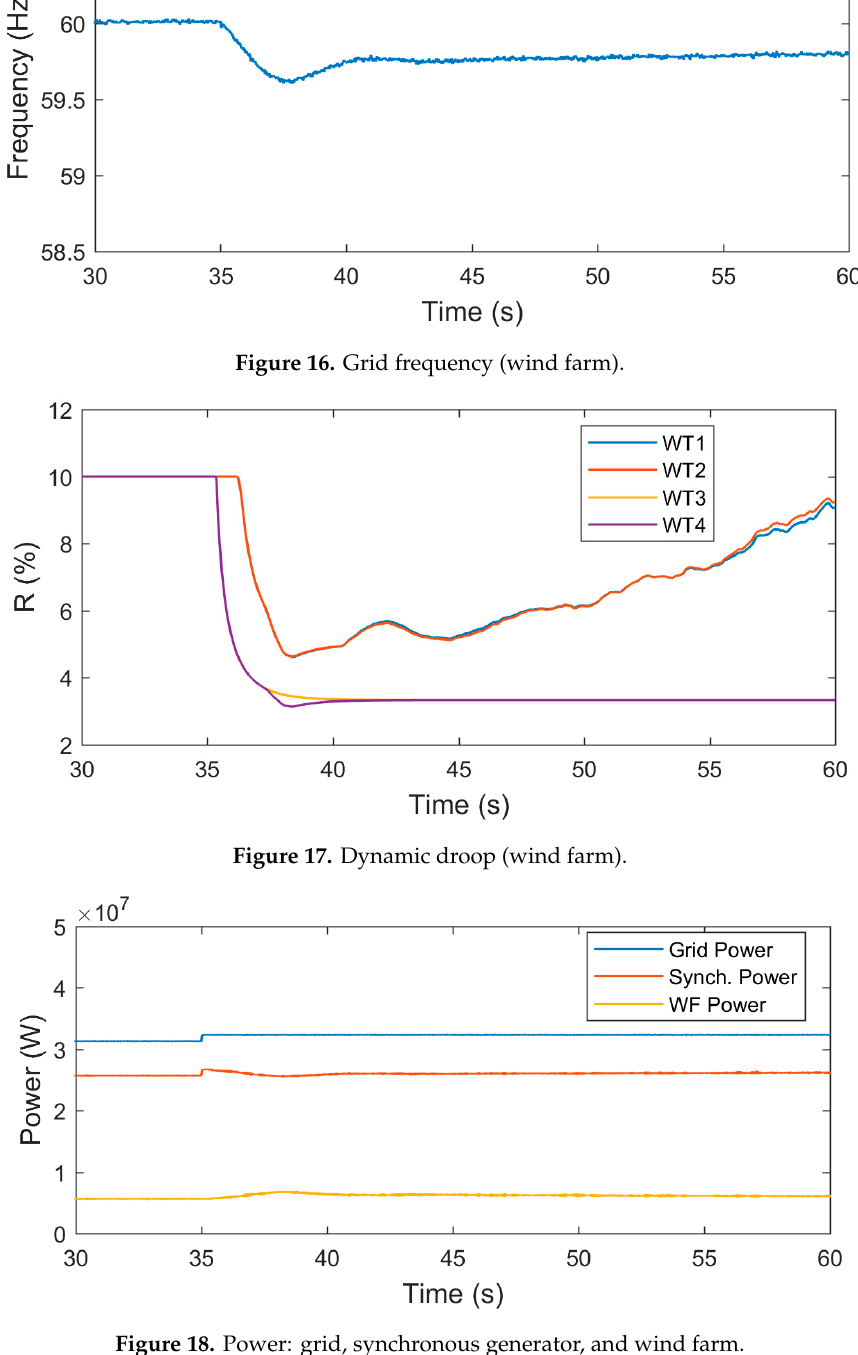
Figure 19. Wind energy systems power (wind farm). Figure 20. Rotor speed (wind farm).